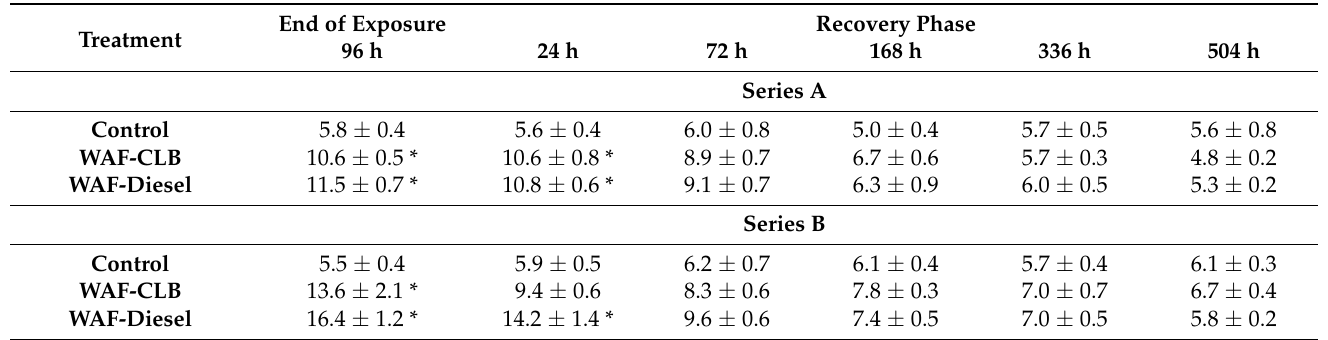
Table 6. EROD activity in lobster hemolymph for each treatment (Control, WAF-CLB, and WAF-Diesel) during the recovery period in series A and B. Mean ± SE; n = 3.